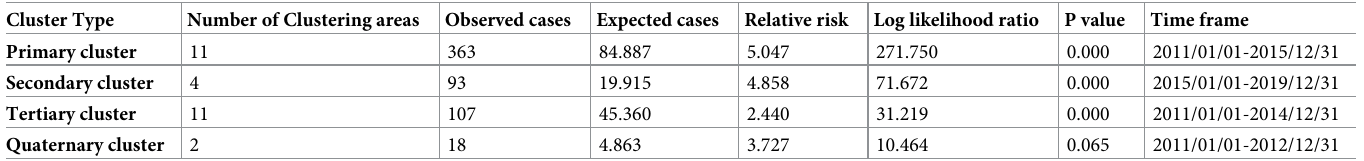
Table 5. The result of spatial-temporal analysis of new detected leprosy cases in Yunnan, China, 2011–2020. Cluster